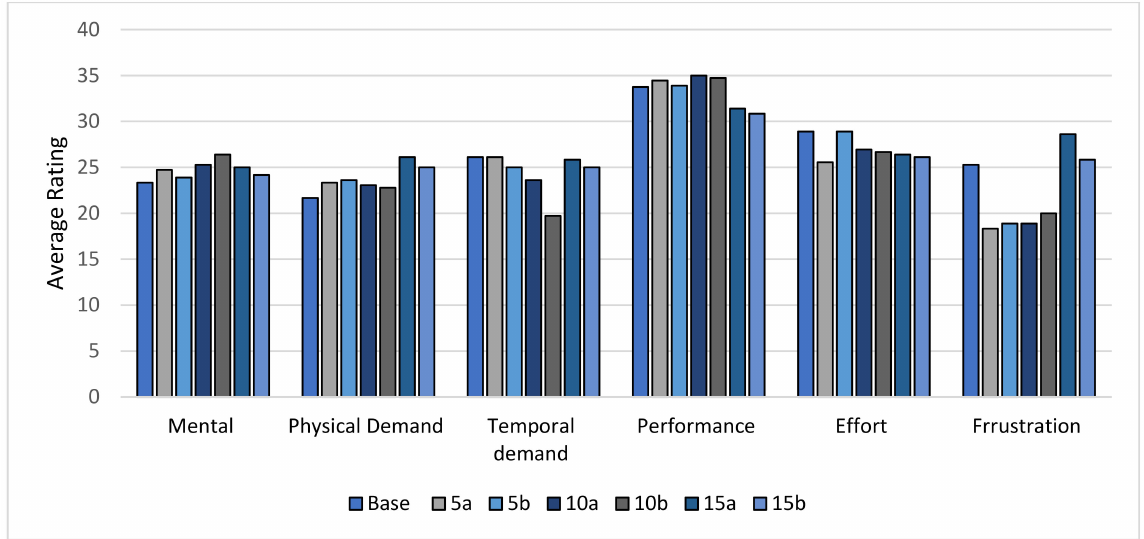
Figure 14. Average rating of NASA-TLX for an overtaking vehicle session.